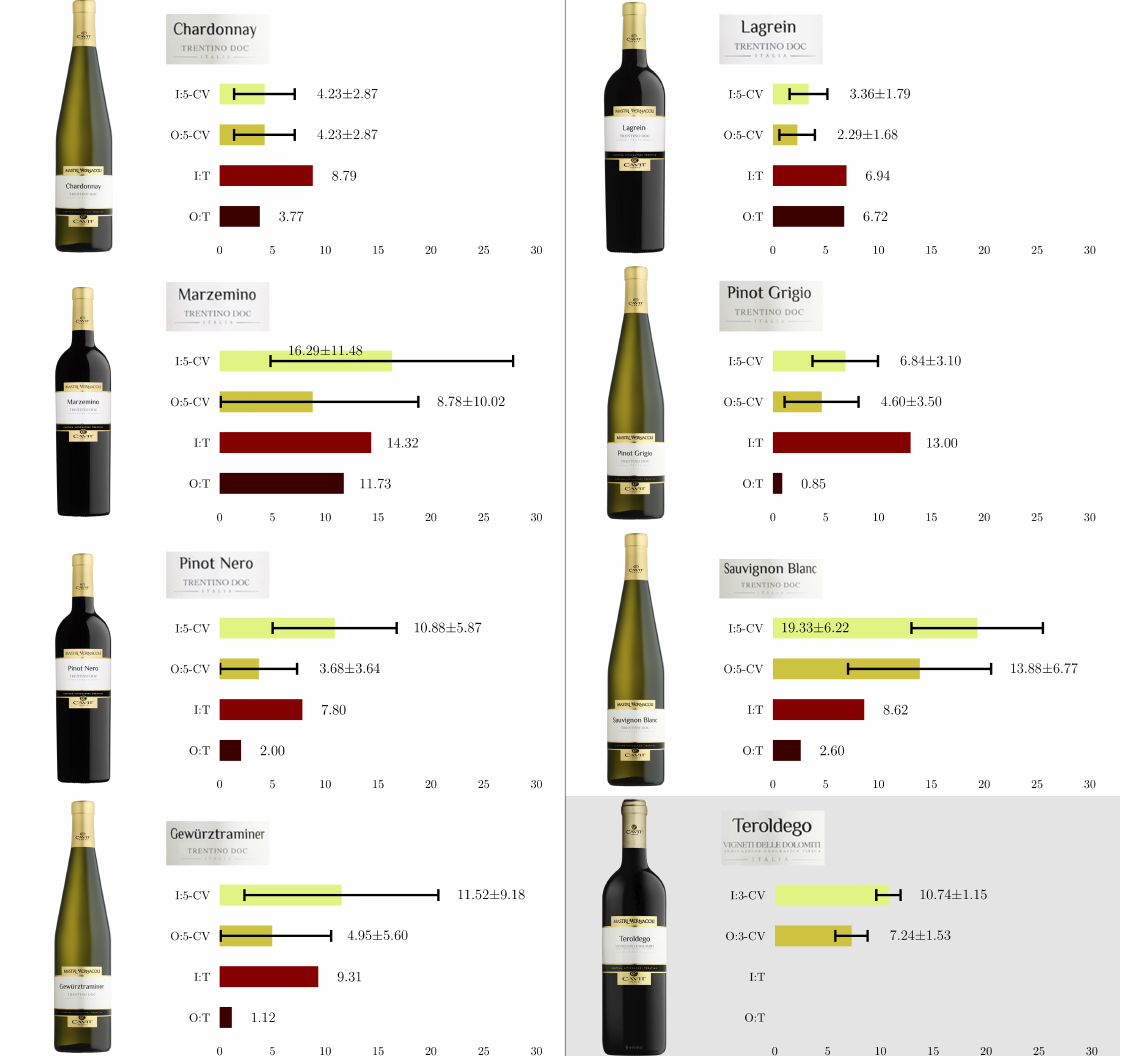
Figure 7. Mean Average Error (MAE) (%) achieved by GBCNet in both cross validation (CV) (5 for CR1 3 for CR2) and test mode by image (I) and overall (O) for all the 8 grape varieties in the two datasets CR1, CR2. All varieties with white background belong to CR1, while Teroldego, in gray background, is CR2. Results are formally reported as mean ± sd, where sd may be larger than